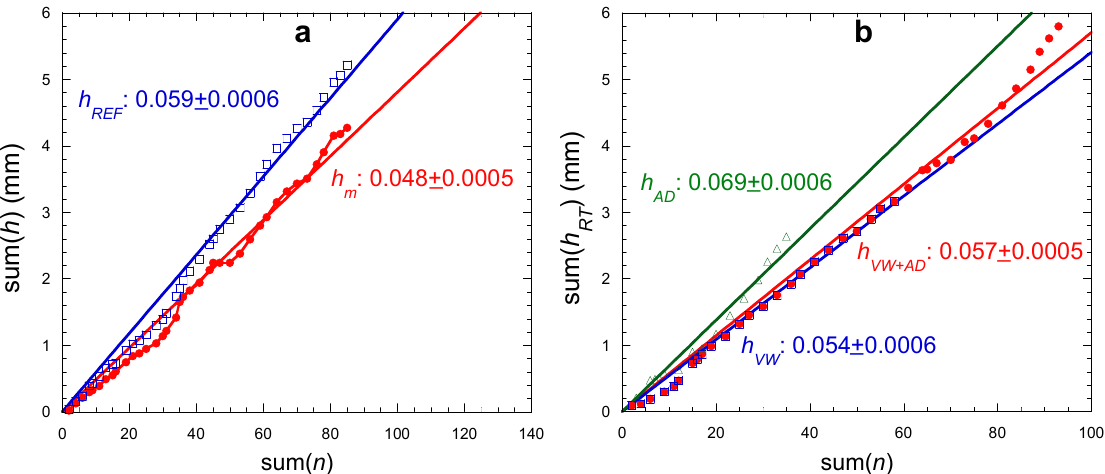
Figure 18. ( a ) Variation of sum( h m ) (red dots) and sum( h REF ) (blue open squares) as a function of the visual scale sum( n ). The values correspond to the result of linear fits (straight lines, uncertainties: One SD). ( b ) Variation of sum( h RT ) for VW rooftop (blue open squares), AD rooftop (green open triangles) and VW + AD rooftops (red dots). The values correspond to the result of linear fits (straight lines, uncertainties: One SD).